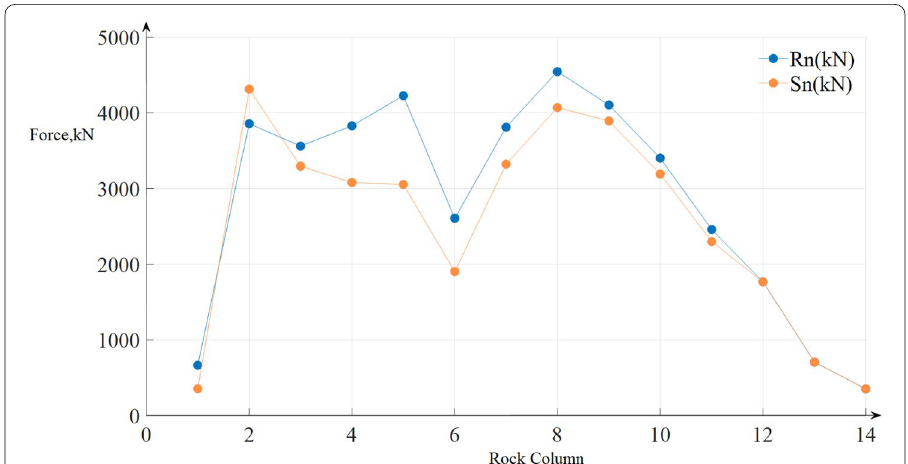
Fig. 9 Distribution of normal (R) and shear (S) forces on the bases of blocks without any external influence under limit equilibrium methods